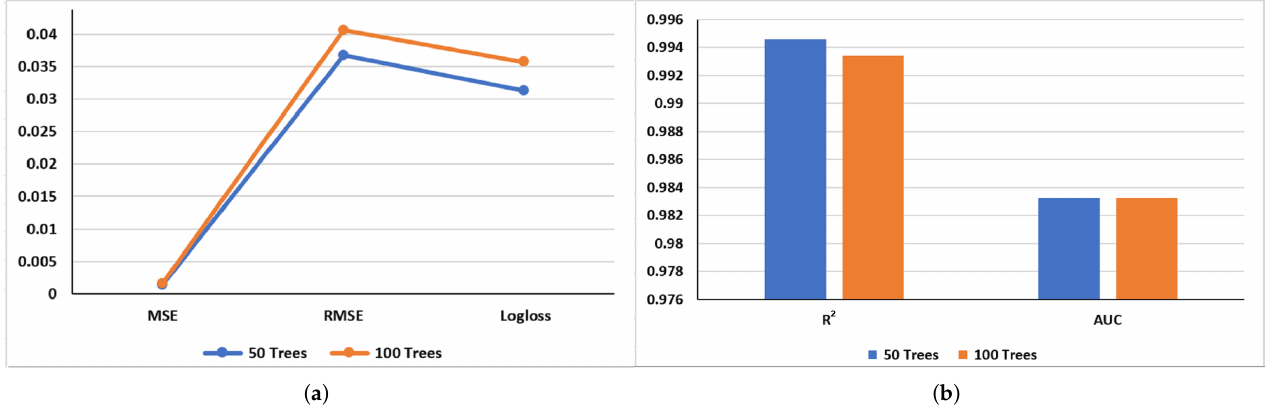
Figure 6. Impact of the increased number of trees on the model. ( a ) MSE, RMSE, and logloss; ( b ) R 2 and